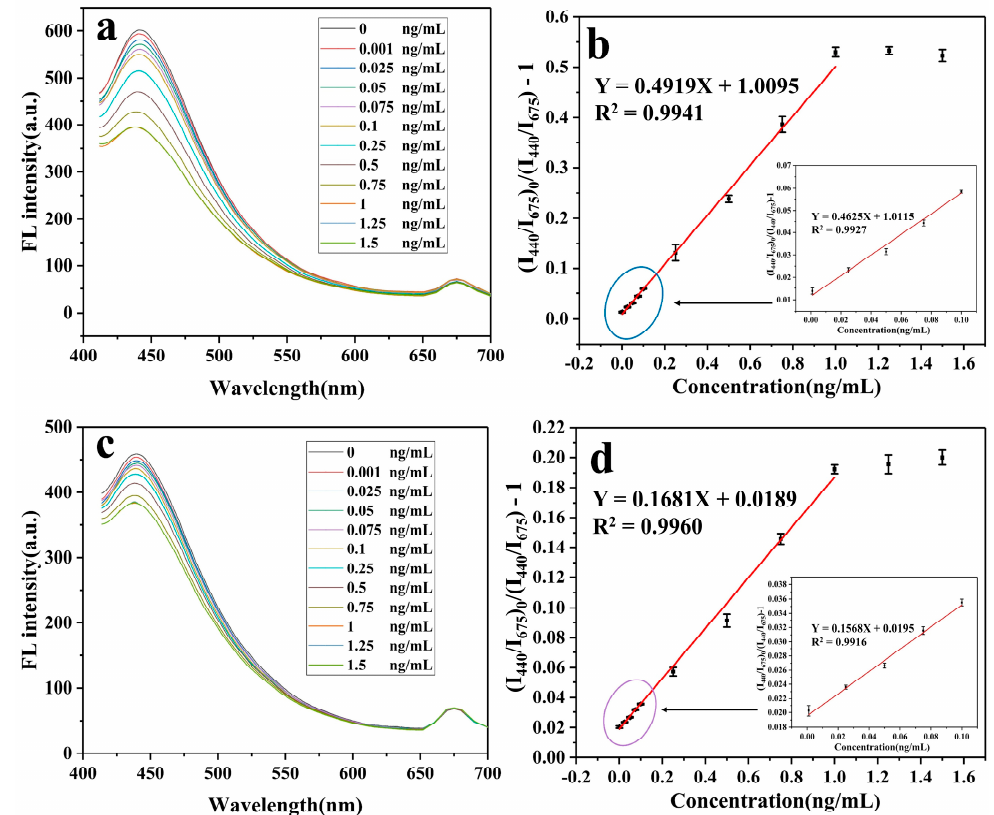
Figure 3. ( a , c ) Fluorescence quenching diagrams and ( b , d ) Stern–Volmer curves for ( a , b )